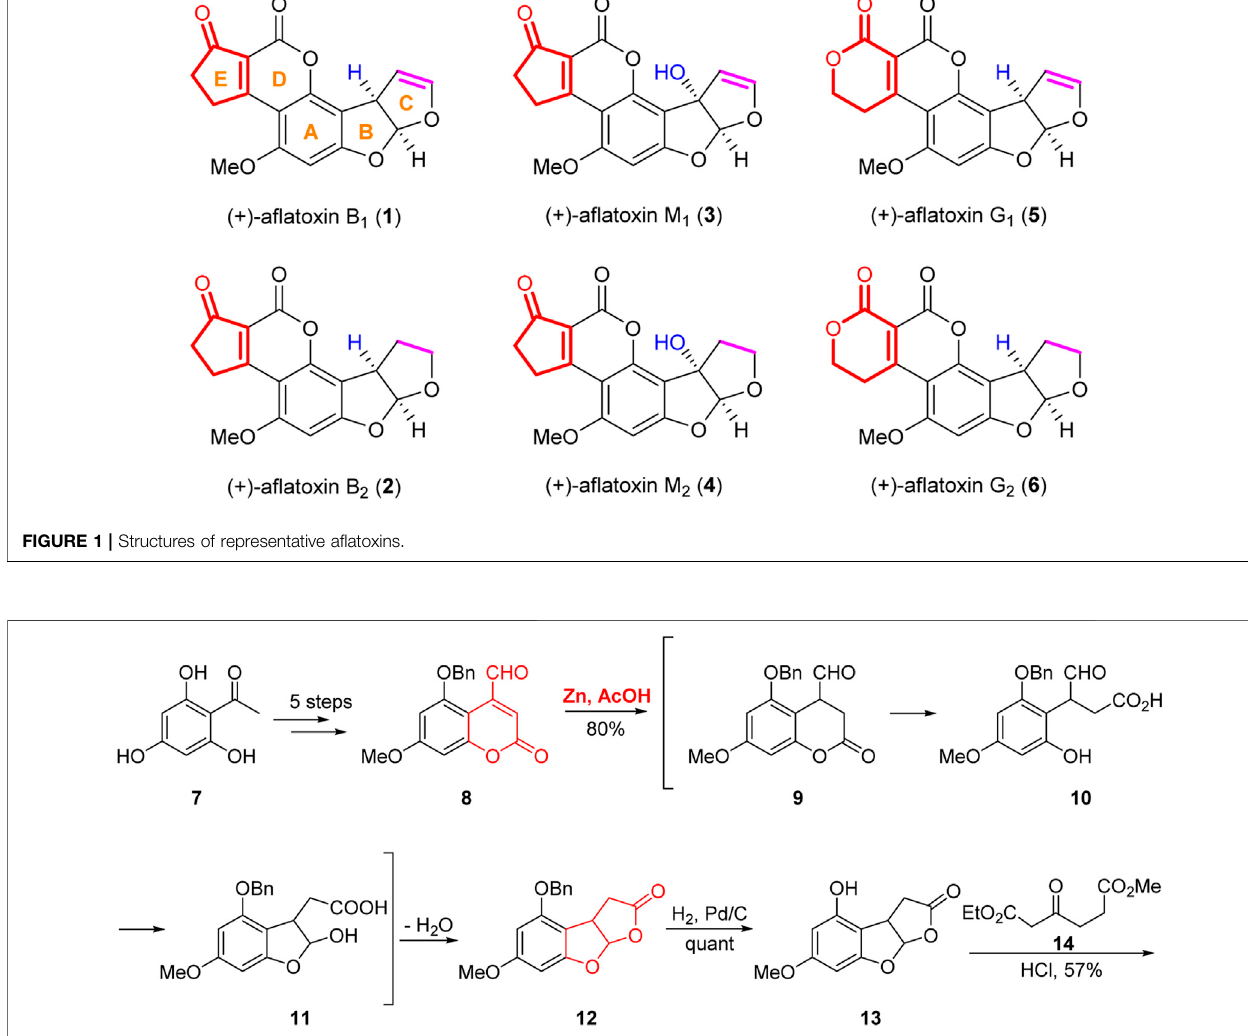
1 by Büchi group.